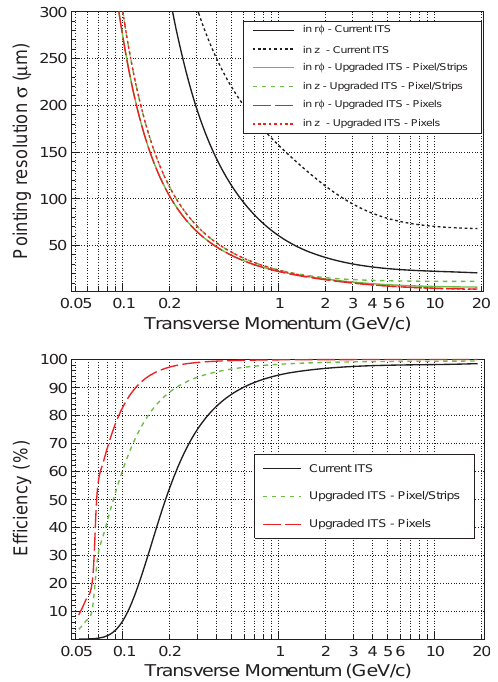
Figure 4. Expected performance of new ITS compared to current ITS. Top: pointing resolution together with TPC as functions of p T , for di ff erent configurations. Bottom: track finding e ffi ciency with only ITS as functions of p T